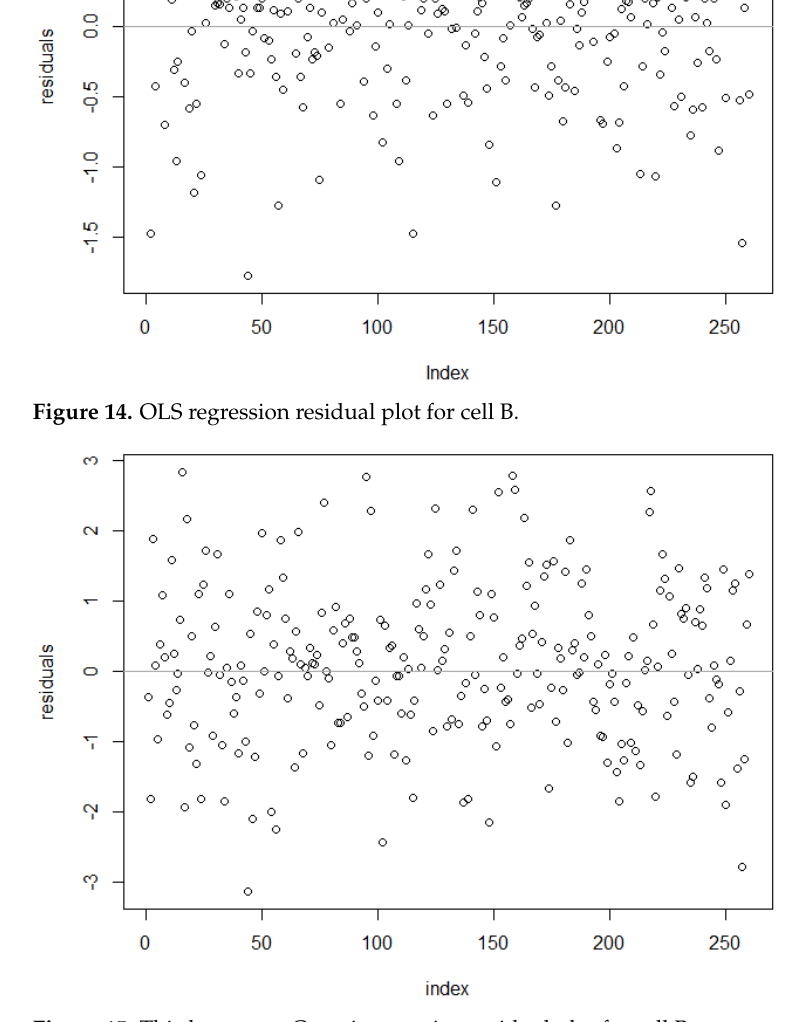
Figure 15. Third-moment Catoni regression residual plot for cell